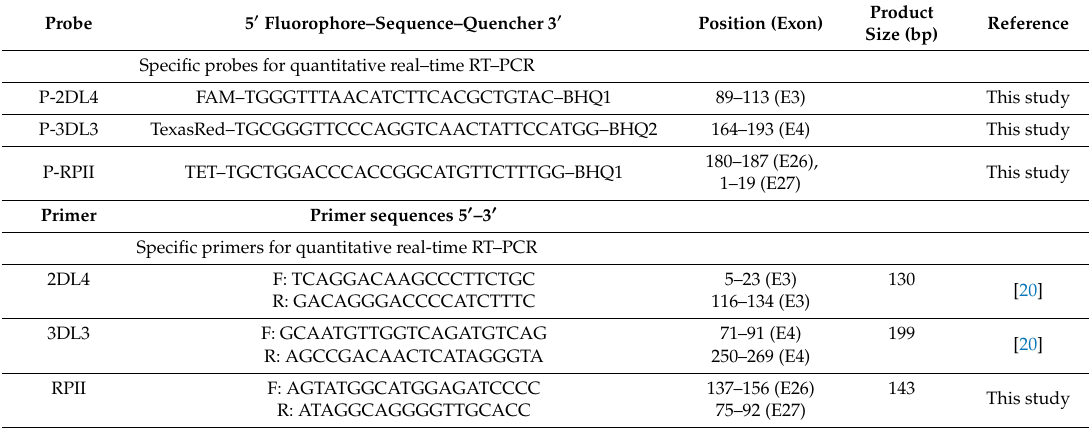
Table 1. Primer and probe sequences used in this